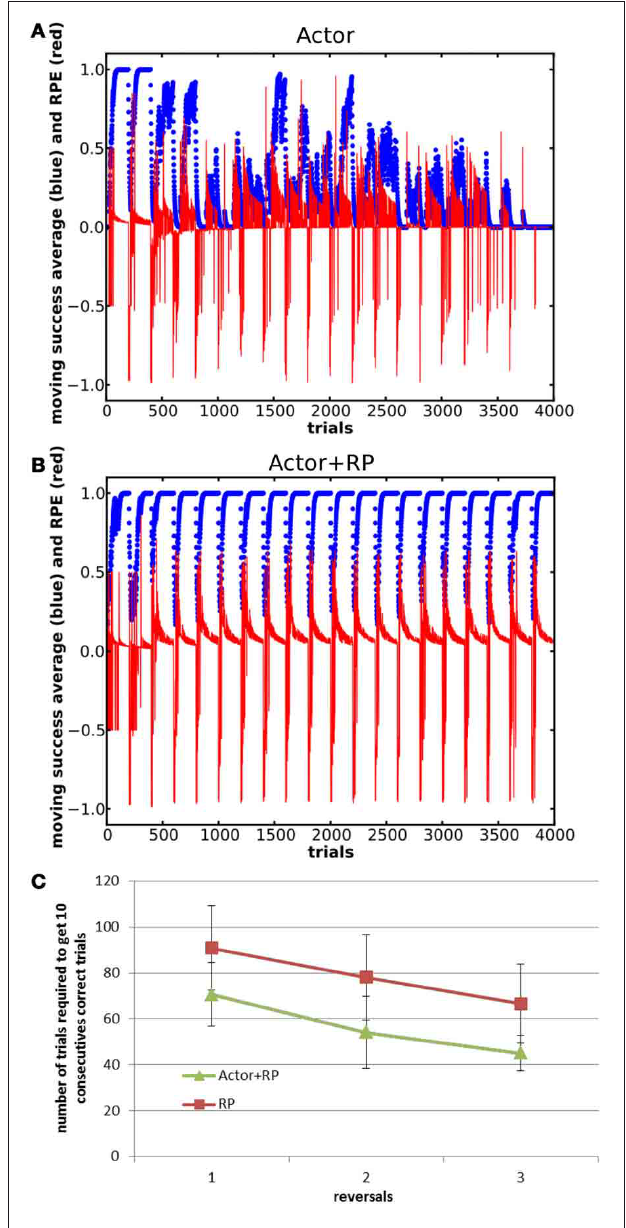
FIGURE 8 | Moving average of the success and RPE for Actor (A) and Actor+RP (B) in a reversal learning task consisting of 20 blocks of 200 trials each. Panel (C) shows savings effects for Actor + RP and RP as the systems relearns the same mapping. Error bars represent standard